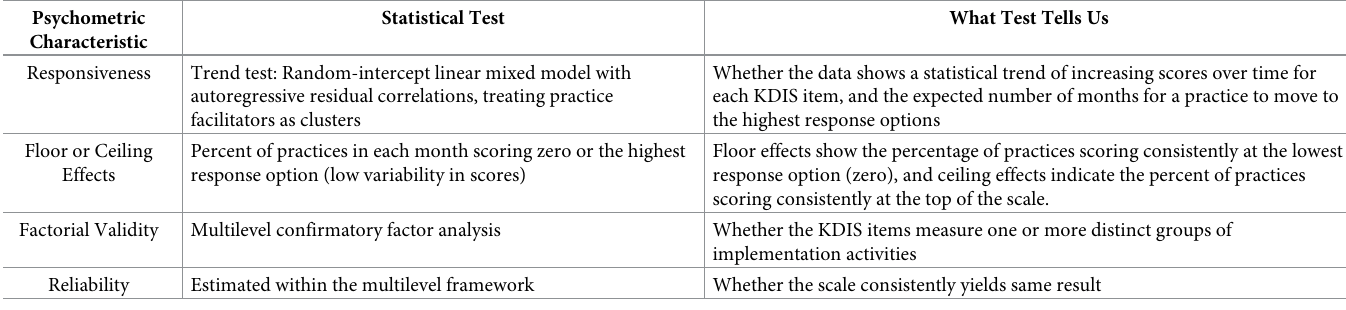
Table 3. Overview of psychometric